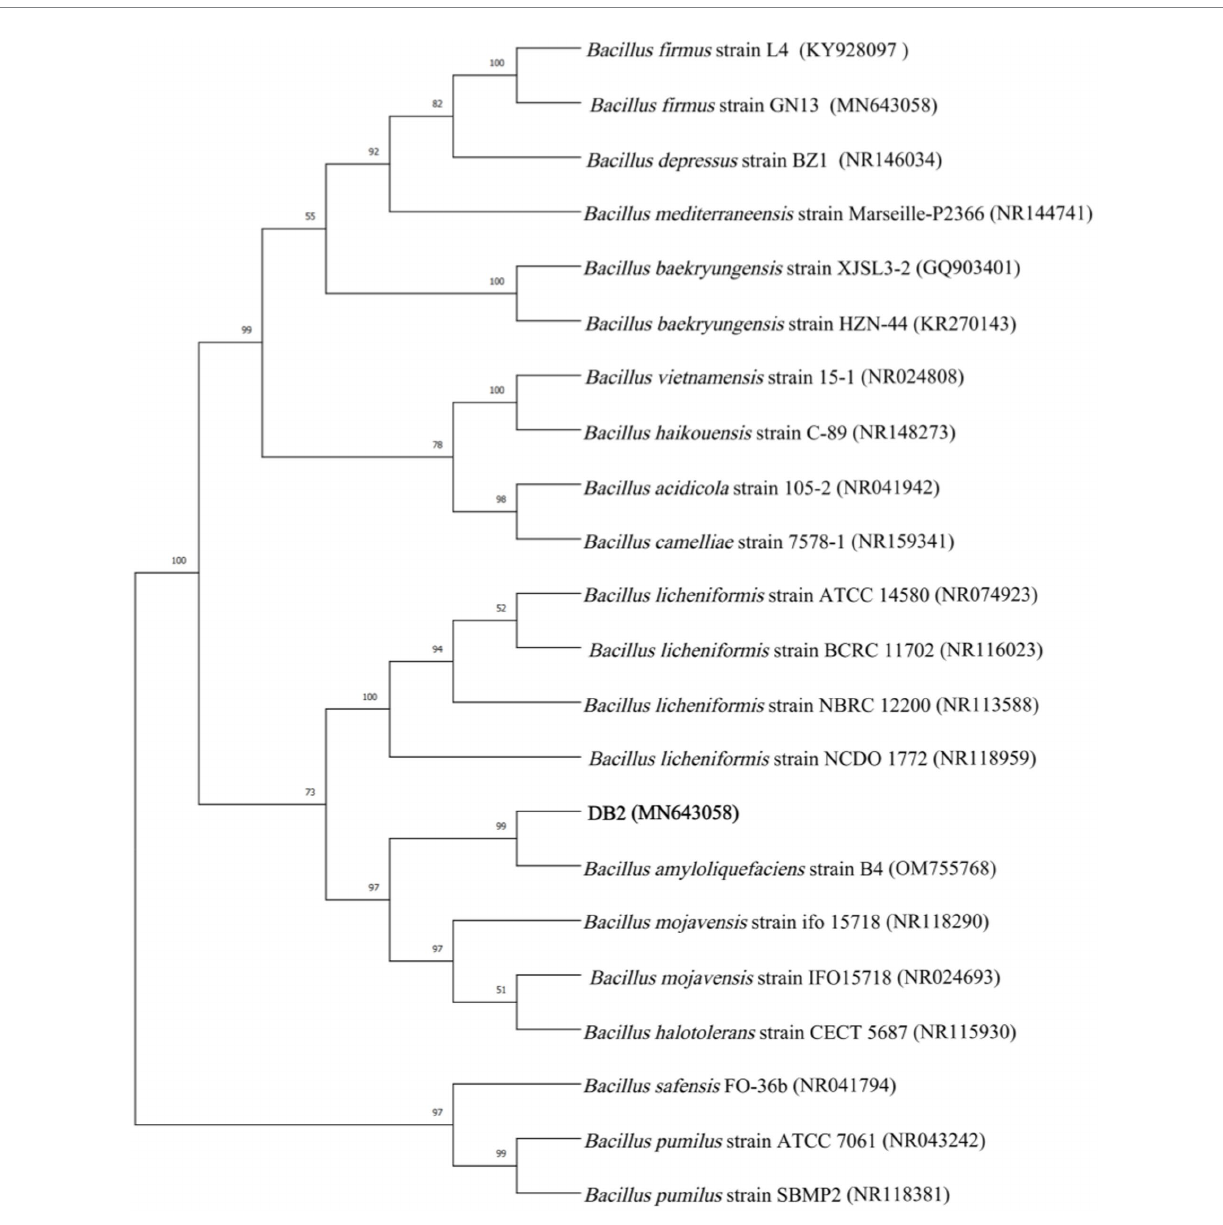
FIGURE 1 Phylogenetic tree of Bacillus amyloliquefaciens DB2 constructed on 16S rDNA sequence. The analysis was performed using the soft MEGA